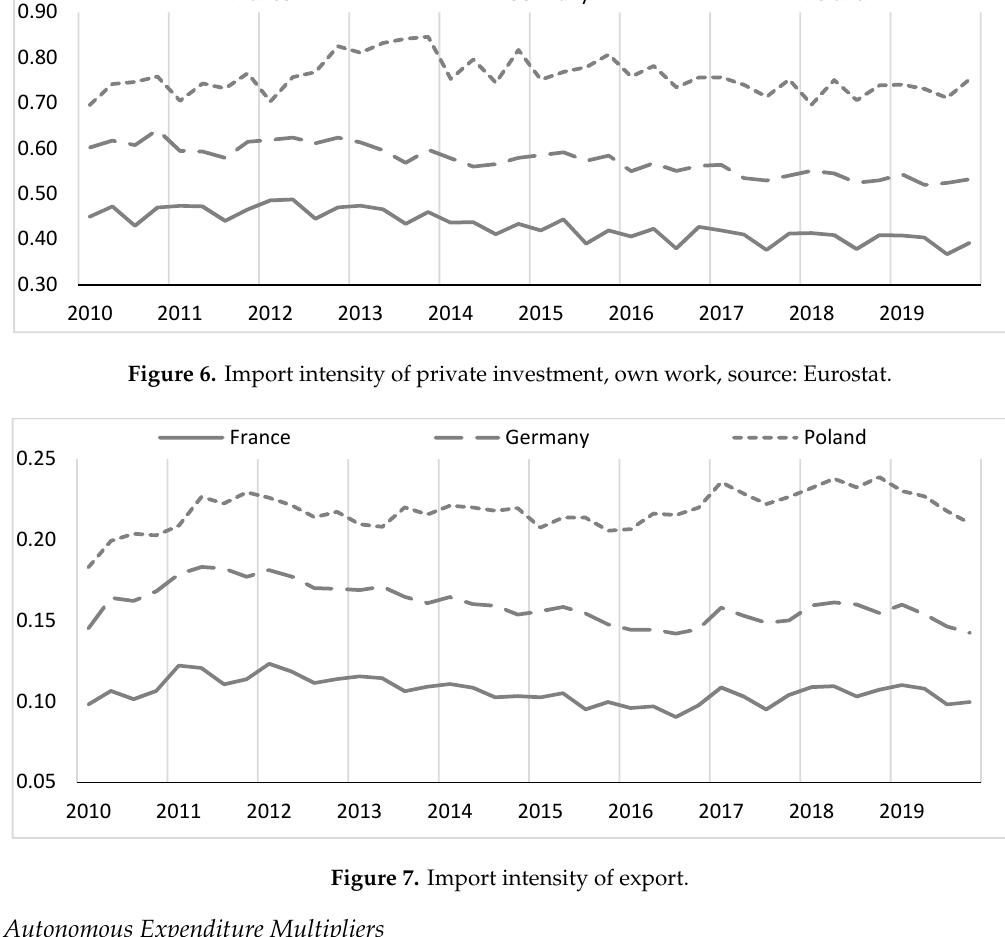
Figure 5. Import intensity of government expenditure, own work, source: Eurostat.